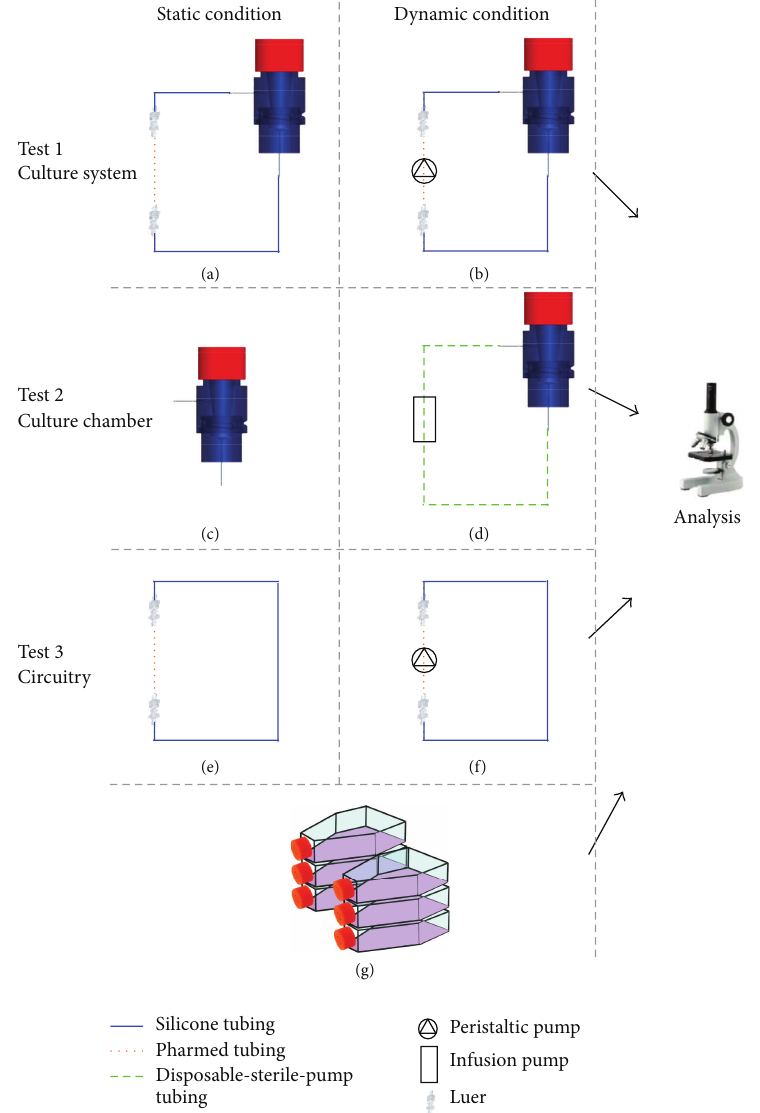
Figure 2: Static (a, c, e) and dynamic (b, d, f) tests performed for evaluating the bioreactor sterility maintenance. Test 1: evaluation of the culture system (Ismatec multichannel peristaltic pump, fluidic circuit and culture chamber) (a, b). Test 2: evaluation of the single culture chamber (c) with a disposable-sterile-silicone-pump tubing Infusomat Standard (BBraun) and fed in the infusion pump Infusomat fmS (d). Test 3: evaluation of the preassembled circuitry alone in static (e) and dynamic (f) condition, where an Ismatec peristaltic pump is used. As a control, a T-flask containing the same medium, used for all tests, was incubated